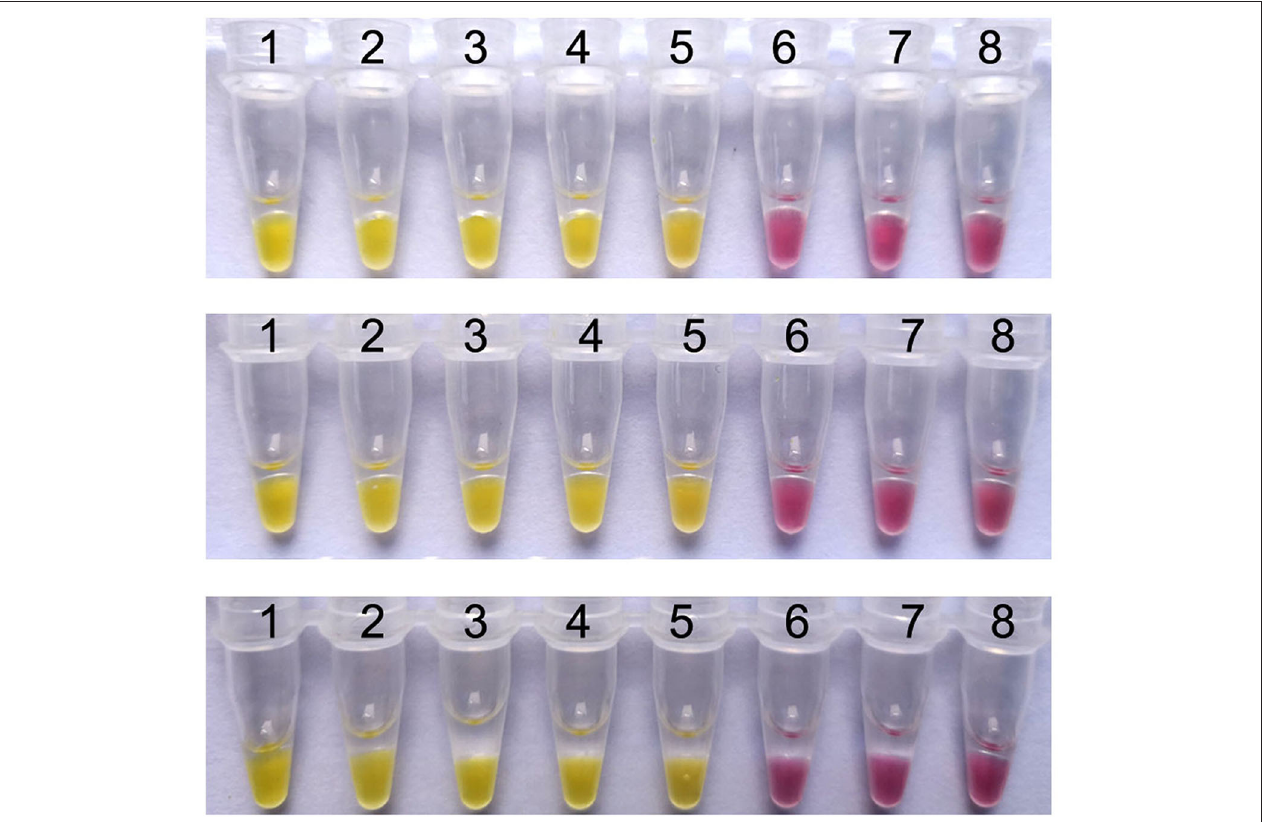
FIGURE 4 | Reproducibility analysis of the colorimetric IMSA. Tubes 1–7, ten-fold serially diluted PMD19T-capsid plasmid DNA (10 5 , 10 4 , 10 3 , 10 2 , 10 1 , 10 0 , and 10 − 1 copies). Tube 8: negative control.